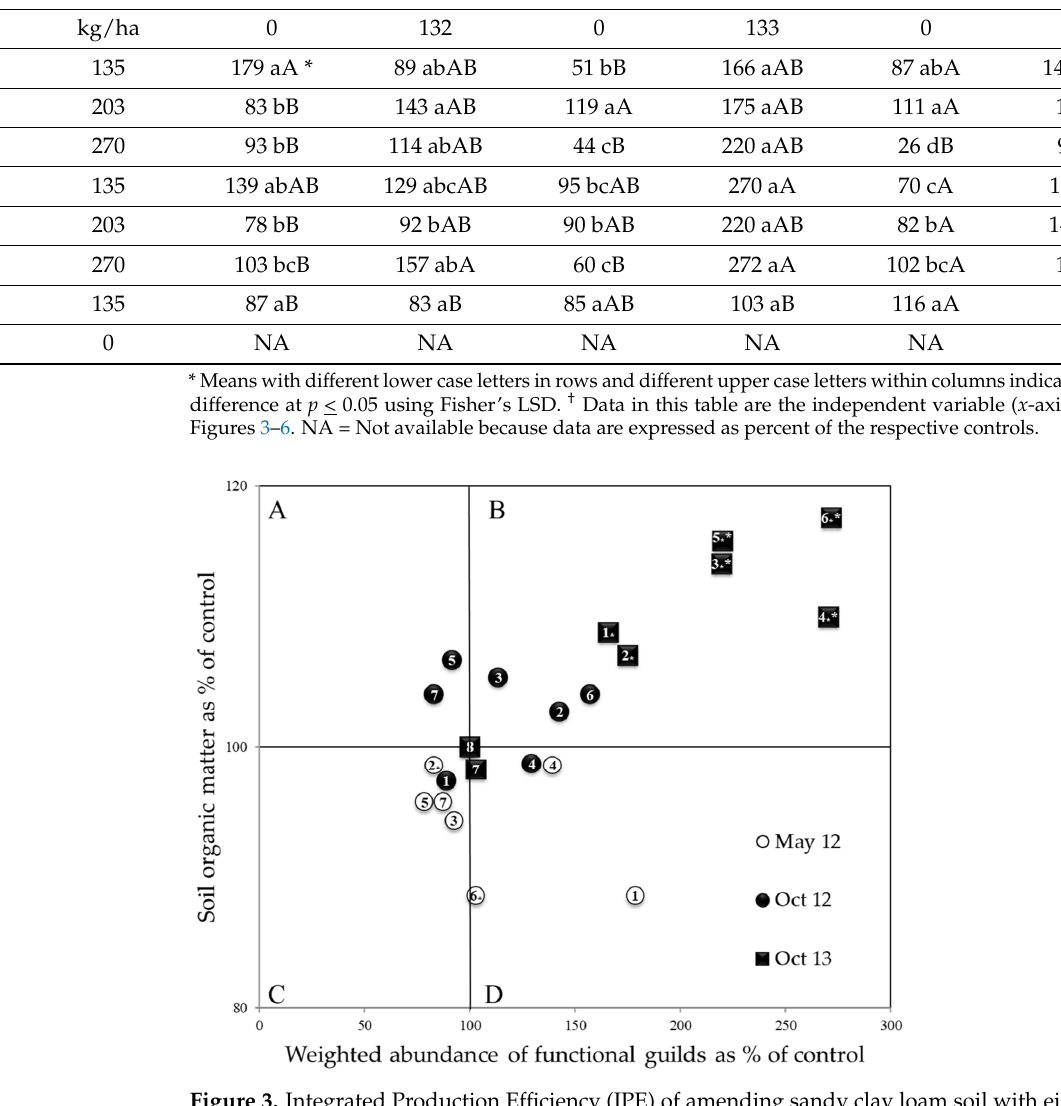
Figure 3. Integrated Production Efficiency (IPE) of amending sandy clay loam soil with either animal (AC) or plant (PC) based compost applied at 135, 203 or 270 kg N/ha planted with processing cultivar on organic matter ( y -axis) and weighted abundance of functional guilds (WAFG, x -axis) of nematodes at planting in May 2012 (May 12) and harvest in October 2012 (Oct 12) and 2013 (Oct 13) growing seasons fitted to the IPE model. Numbers 1–3 refer PC at a rate of 135, 203 and 270 kg N/ha, respectively and 4–6 refer AC at a rate of 135, 203 and 270 kg N/ha, respectively, 7 and 8 refer urea and non-amended check, respectively. * Treatments with subscripts and superscripts asterisks (*) indicate significantly different from 100% for WAFG and soil organic matter, respectively, using one-tailed t -test at α = 0.05. The soil amendment rates and the organic matter data presented here are the same as those in Table S1. The WAFG data presented here are the same as those in Table 1.